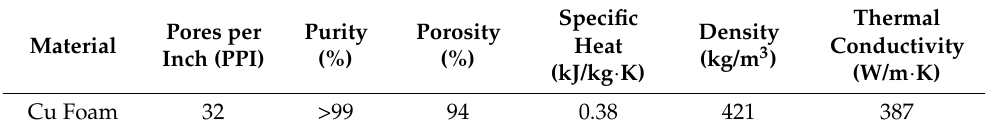
Table 2. Properties of the metallic foam.